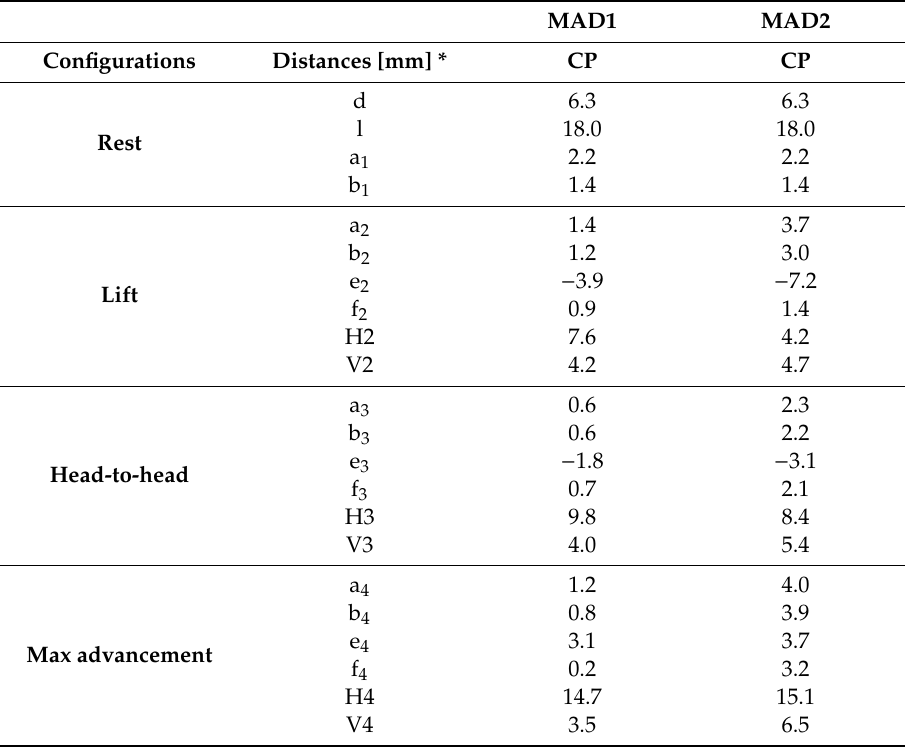
Table 5. Evaluation of the condylar displacement under the usage of the MADs. * The subscript number refers to the i-th configuration.